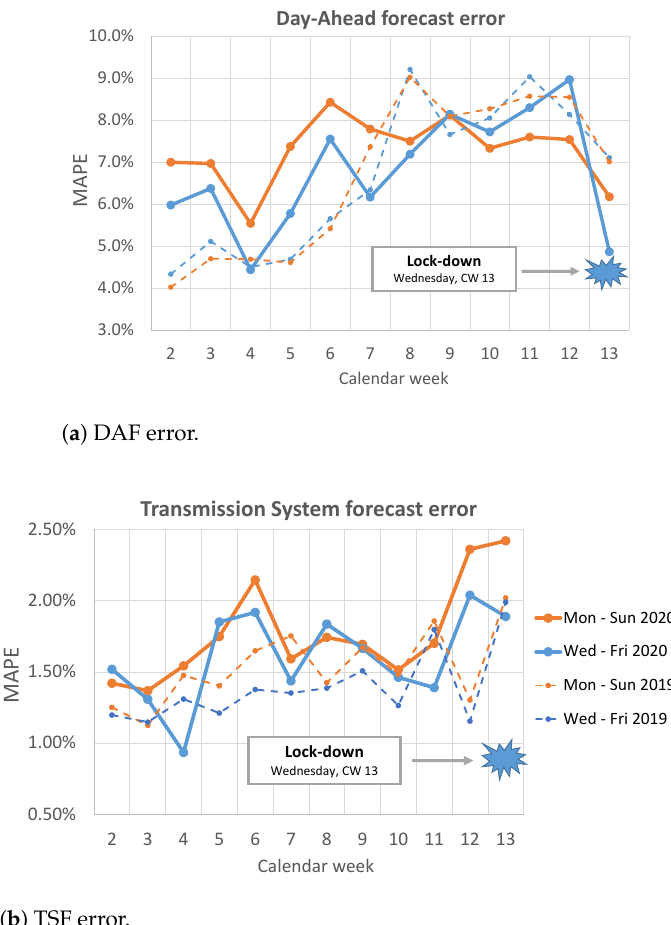
Figure 11. Weekly aggregated total DAF and final TSF error, for the timeframe from (i) Monday to Sunday and (ii) Wednesday to Friday for 2019 and 2020. Note: The Wednesday to Friday frame was used to show the impact of the lockdown from a workday perspective. The lockdown led to a significant improvement of the DAF, while the TSF experience minor